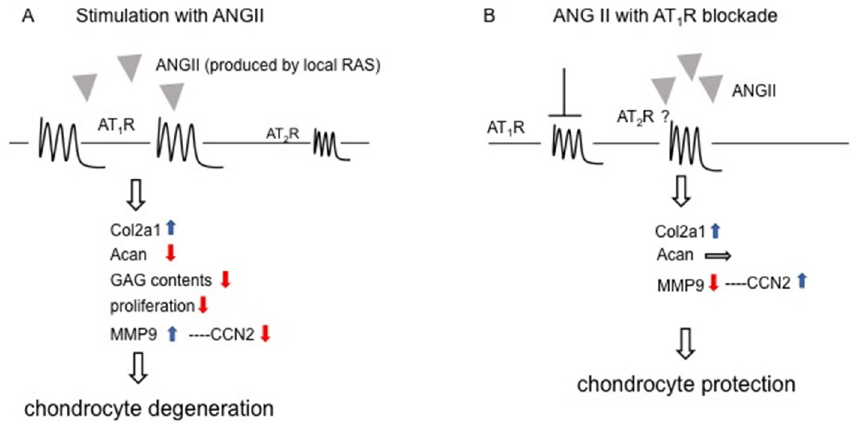
Figure 8. Schematic representation of possible chondrocyte degeneration and protection by the ANG II–AT 1 R axis ( A ) and AT 1 R blockade ( B ), respectively. ( A ) Since AT 1 R is the dominant ANG II receptor in chondrocytes, the ANG II–AT 1 R axis decreases not only Acan expression and GAG accumulation but also the CCN2 level via increased MMP9, leading to chondrocyte degeneration. ( B ) When AT 1 R is blocked by a specific inhibitor, such as losartan, ANG II interacts with AT 2 R instead. The ANG II–AT 2 R axis then increases the CCN2 level via decreased MMP9, leading to chondrocyte protection. Gray triangles indicate ANG II. Blue and red arrows show upregulation and downregulation, respectively, and horizontal arrow indicates no effect. The question mark represents the possible interaction of ANG II with AT 2 R, when AT 1 R is blocked by a specific inhibitor.